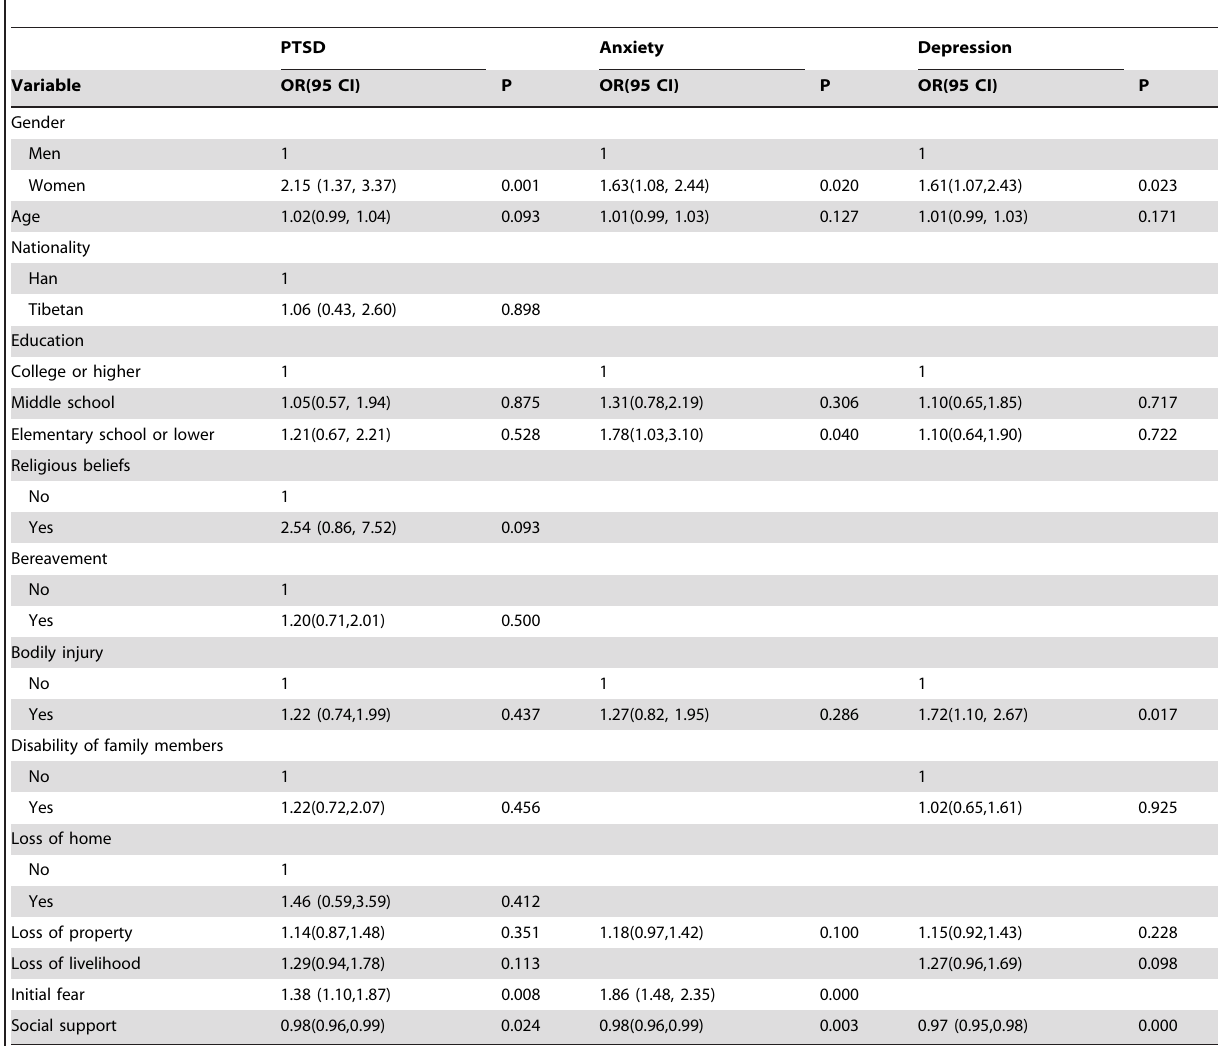
Table 4. Multivariate logistic regression analyses of the factors significantly associated with PTSD, anxiety and